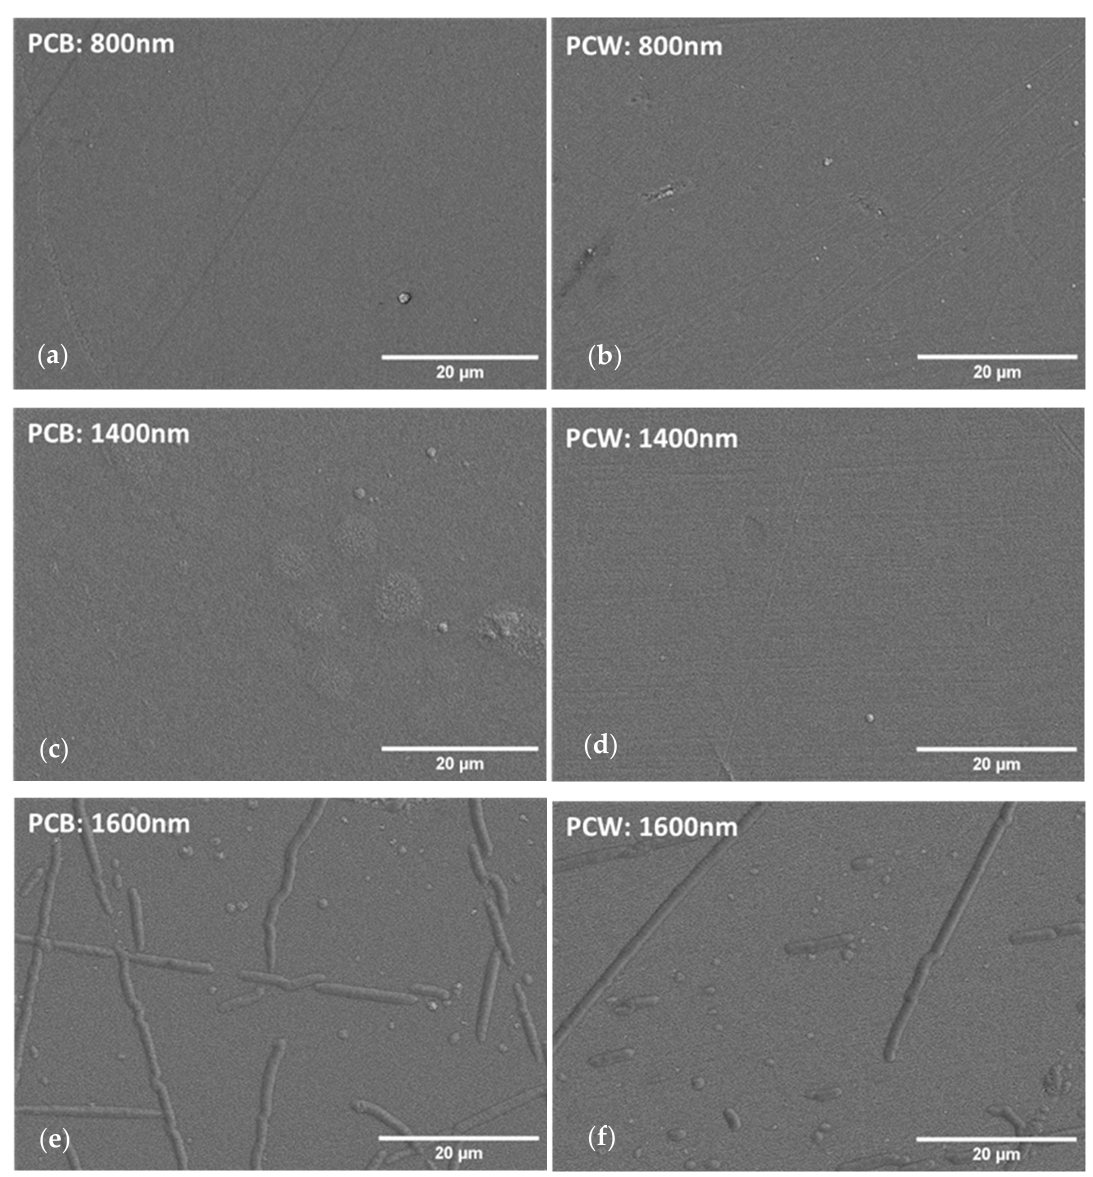
Figure 2. SEM top-view micrographs of coatings with different thicknesses deposited on polymeric substrate: ( a ) 800 nm (PCB), ( b ) 800 nm (PCW) ( c ) 1400 nm (PCB), ( d ) 1400 nm (PCW), ( e ) 1600 nm (PCB), and ( f ) 1600 nm (PCW).